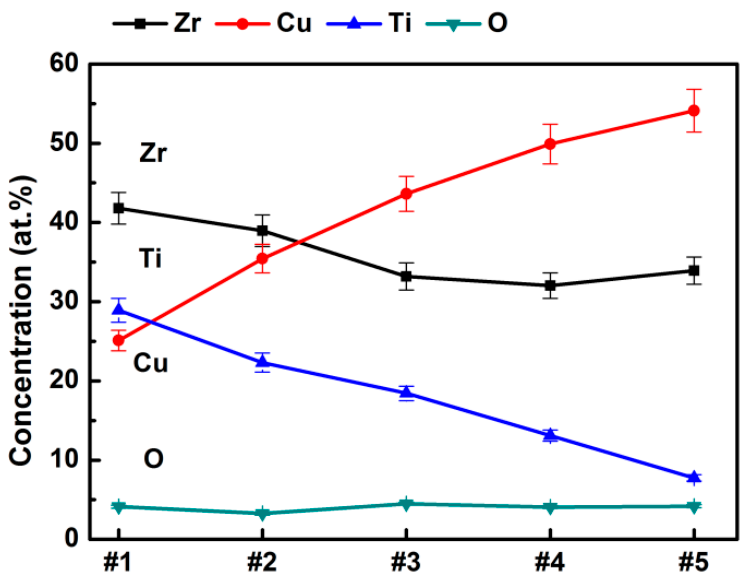
Figure 2. Evolution of chemical composition of Zr-Cu-Ti as a function of sputtering powers.